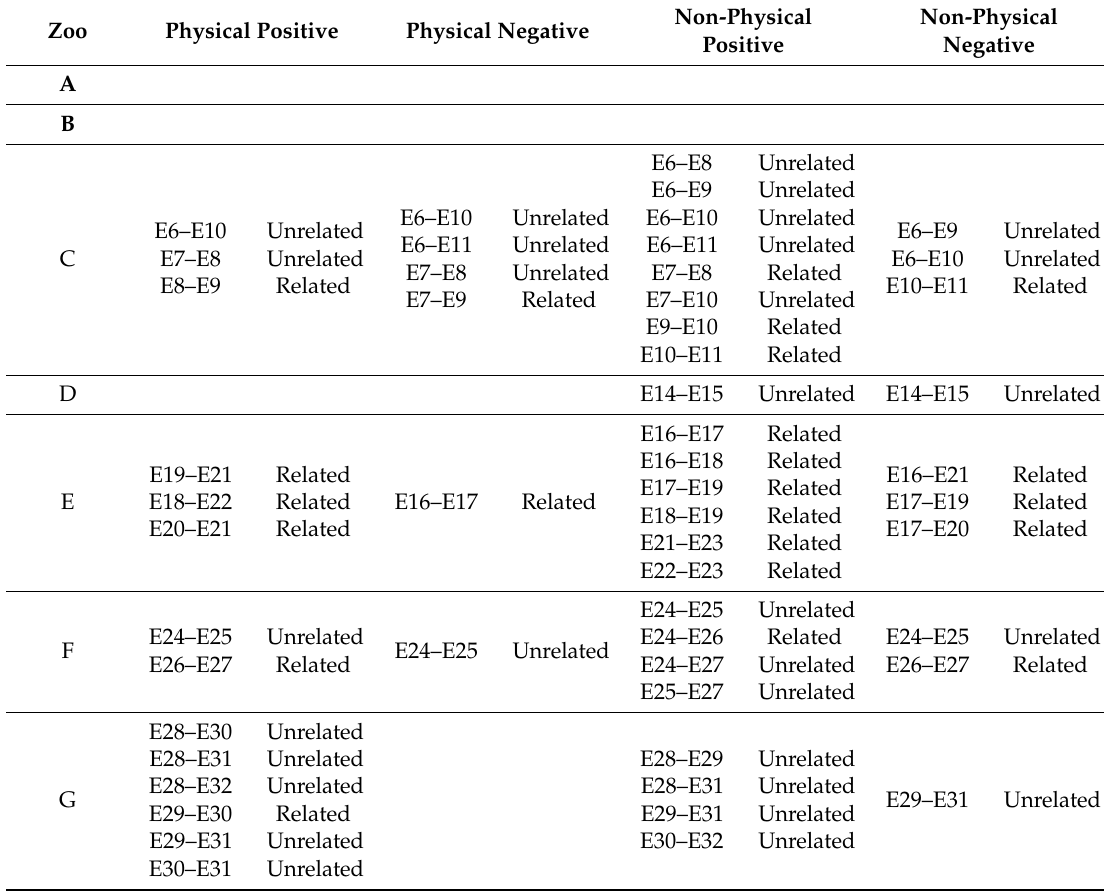
Table 9. Dyadic relationships considered to be balanced (assessed using simple ratios) in the study herds.